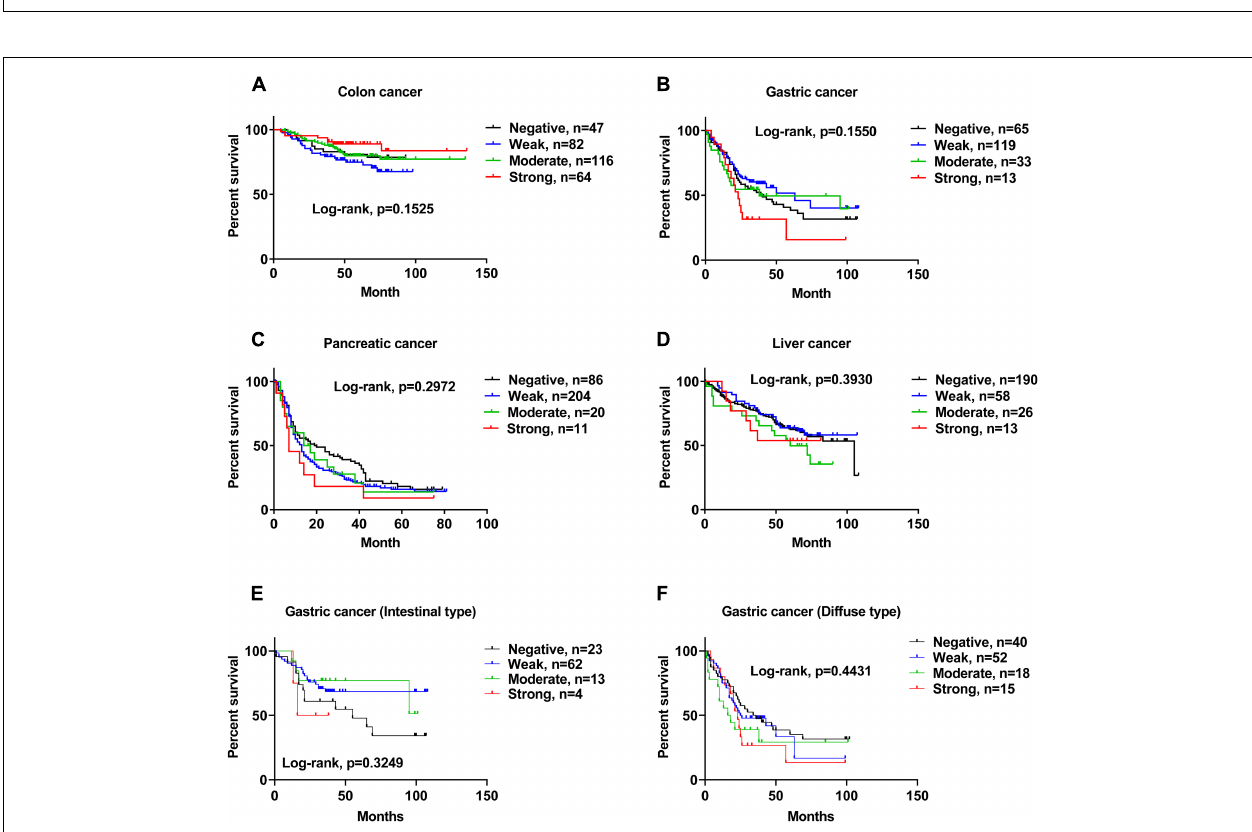
FIGURE 4 | The protein expression level of ACE2 was not correlated with the survival of patients with gastrointestinal cancers. (A–F) Kaplan–Meier analysis of overall survival in the set of patients with colon cancer (A) , gastric cancer (B) , pancreatic cancer (C) , liver cancer (D) , intestinal-type gastric cancer (E) , and diffuse-type gastric cancer (F)